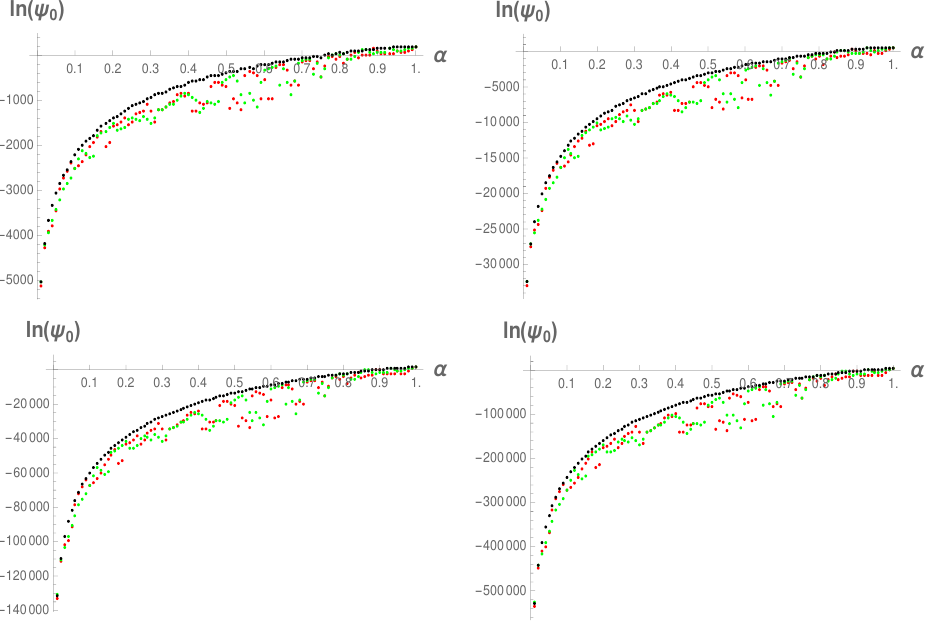
Figure 6 . Comparison of the estimator in subsection 6.3 calculated with discretization into 20 (green) and 25 (red) parts at N = 100 (top left), N = 250 (top right), N = 500 (bottom left) and N = 1000 (bottom right). The exact matrix elements are shown in